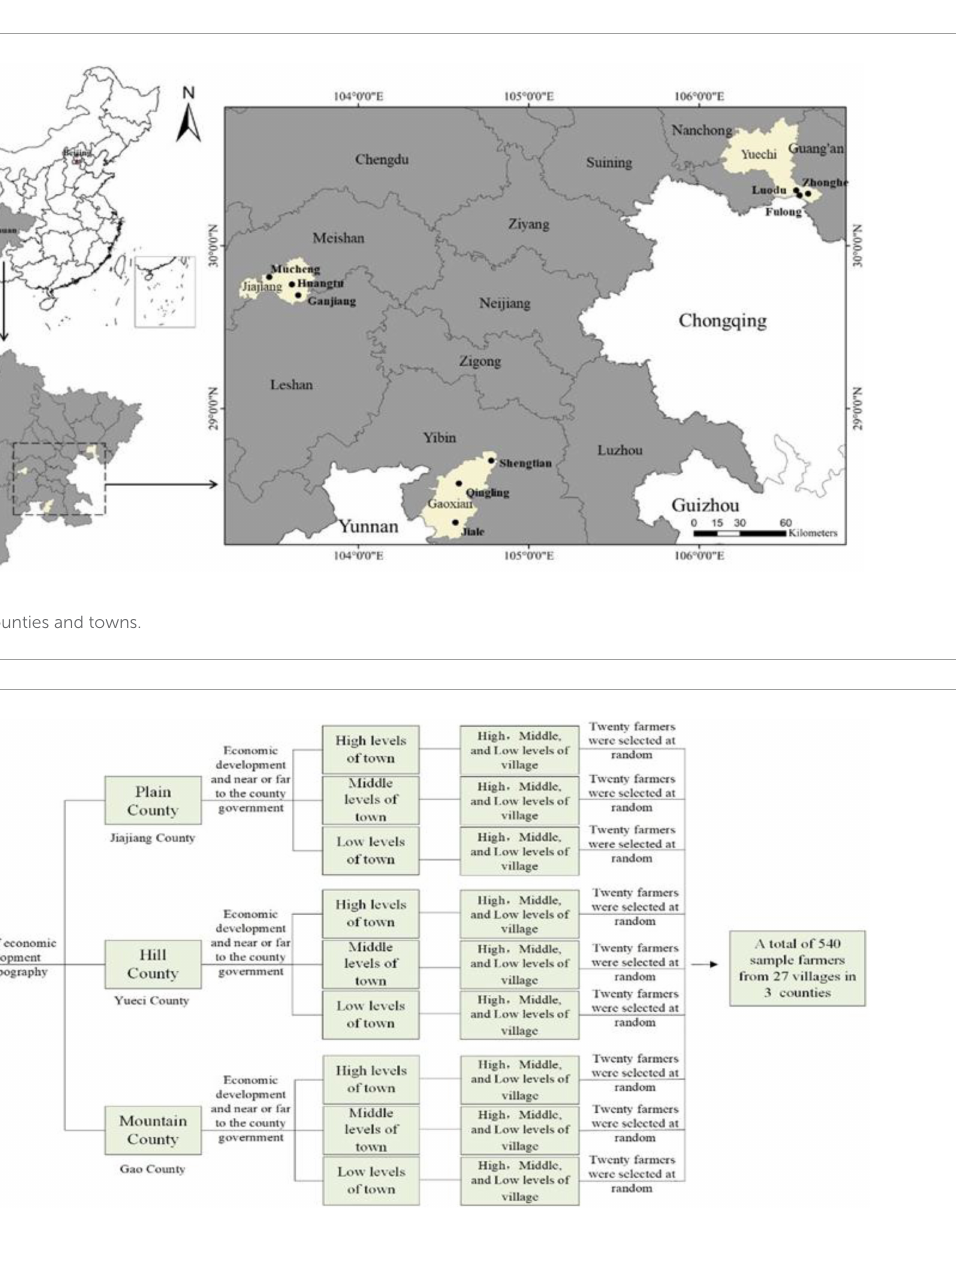
FIGURE3 Survey sampling